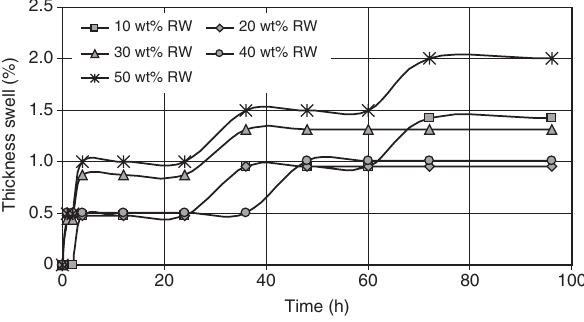
Figure 10 TS as a function of soaking time for different weight percentages of almond shell particle in